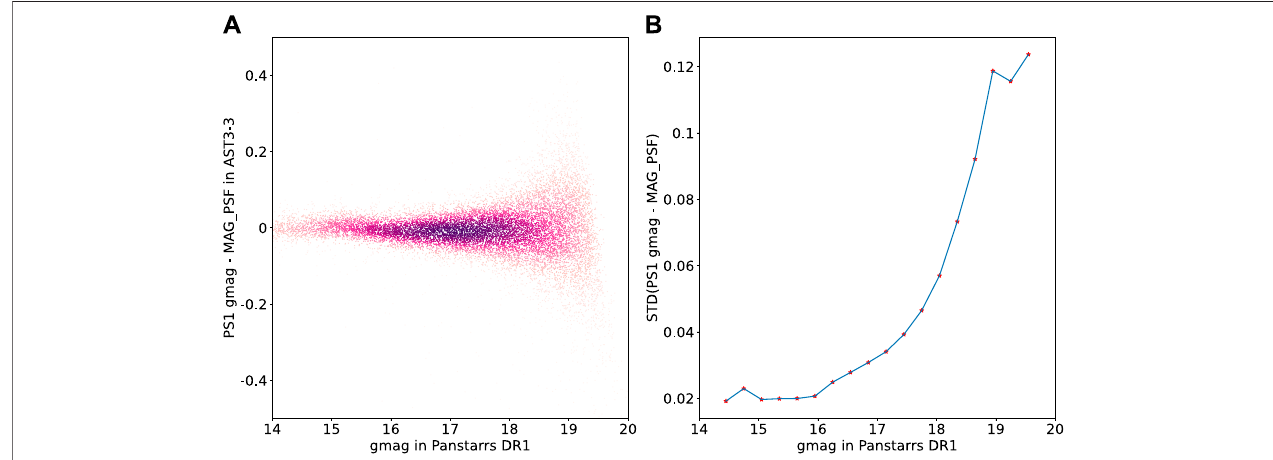
FIGURE 4 | (A) : Difference between the AST3-3 g -band photometry and PS1 g -mag values. (B) : Standard deviation of the binned and sigma clipped difference between the AST3-3 mags and PS1 g -mags.